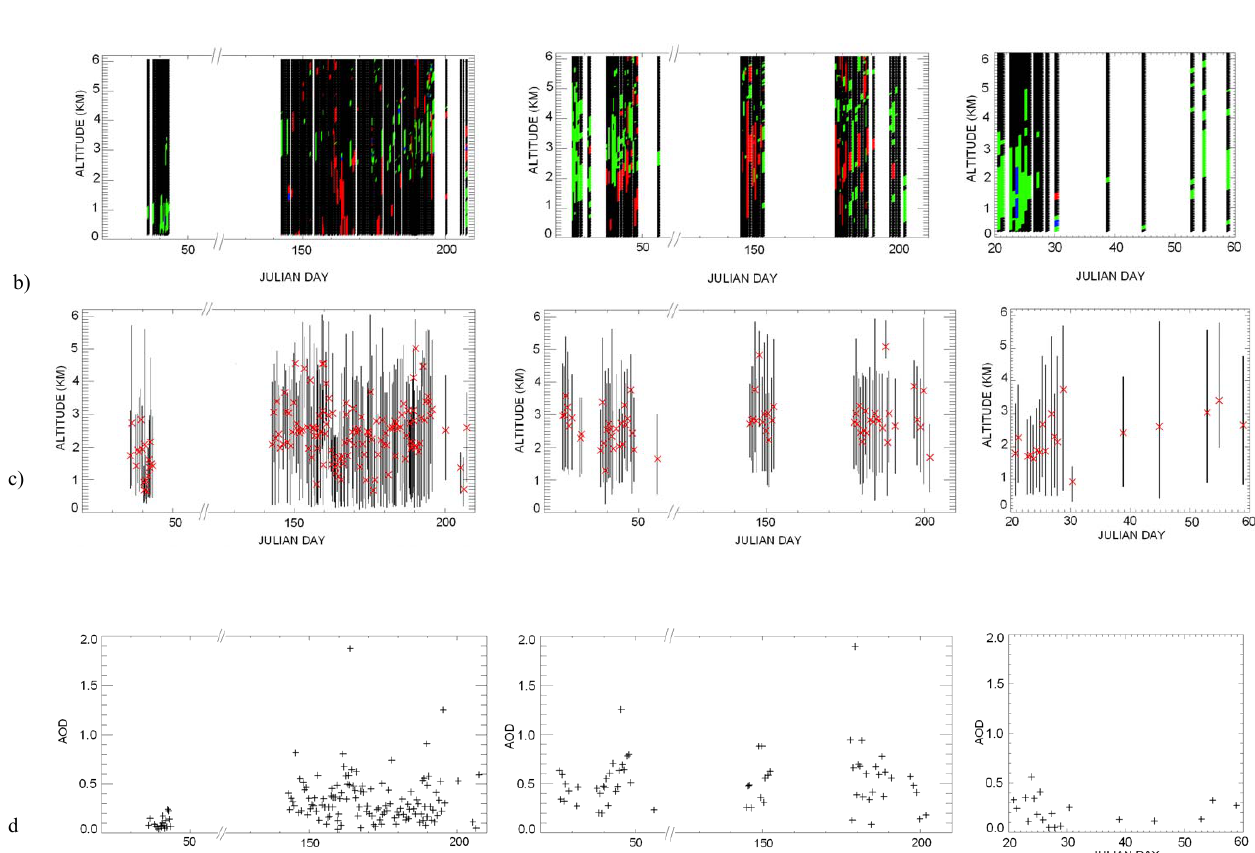
Fig. 1. MULID observations of aerosol extinction coefficient (km- 1 ) profiles (a) , type of aerosol (b) , aerosol occurrence vertical distribution (c) , and aerosol optical depth (d) at three sites Banizoumbou in Niger (left column, 144 observations), Cinzana in Mali (middle column, 48 observations) and M’Bour in Senegal (right column, 19 observations) during 2006. In row (b) intense dust events (DD) are assigned in red, biomass burning aerosol (BBA) in green, mix of DD and BBA aerosols in blue and background aerosol in black. In row (c) top, bottom and barycentre (red cross) of vertical distribution of maximum aerosol load are given.